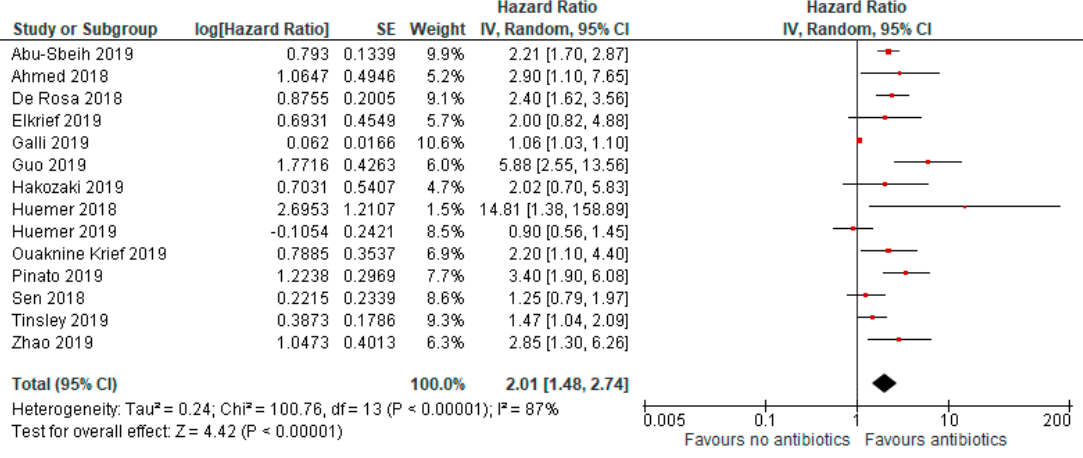
Figure 3. Forrest plot for overall survival in patients assuming antibiotics pre/during